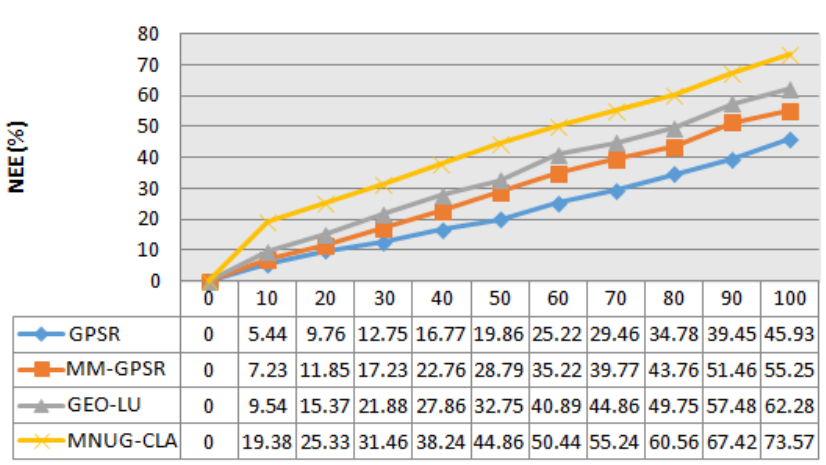
Figure 5. Network Energy Efficiency Calculation.